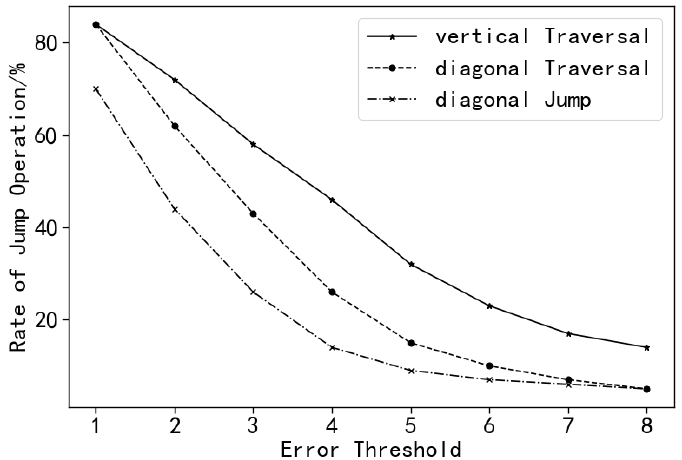
Figure 10. Scale of jump distance